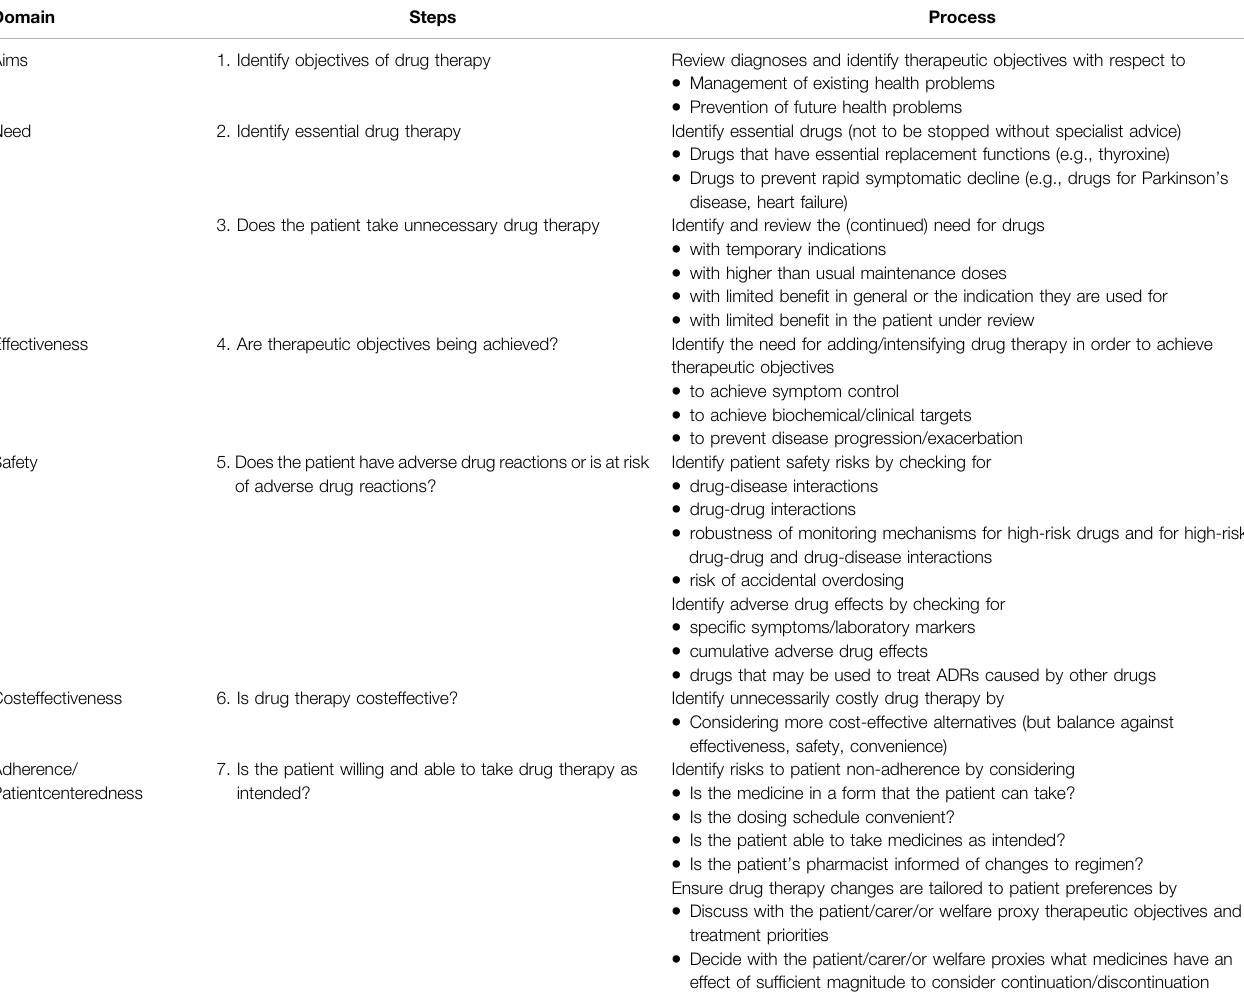
TABLE 3 | An overview of key considerations of 7 Steps of NHS Scotland Polypharmacy Guidance, 3rd edition [from (Wilson et al., 2015), with modi fi cations].